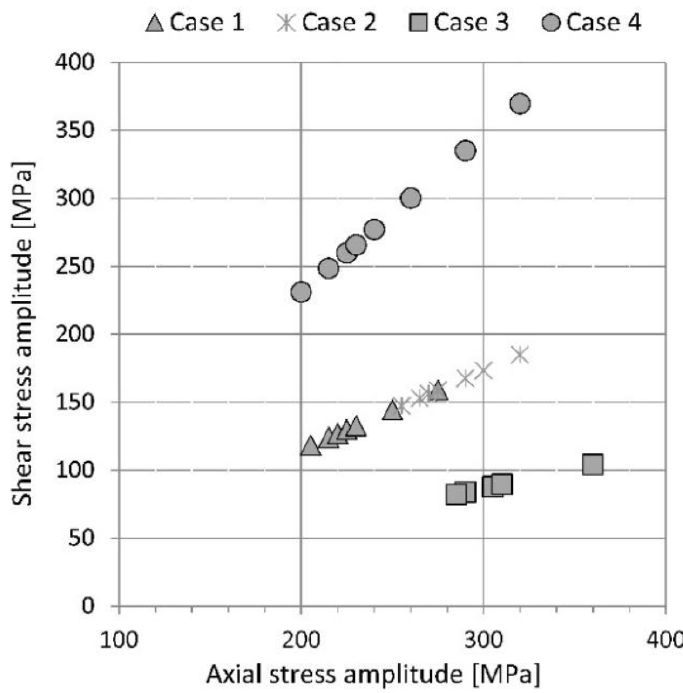
Figure 3. Normal and shear stress amplitudes with R = − 1 used in